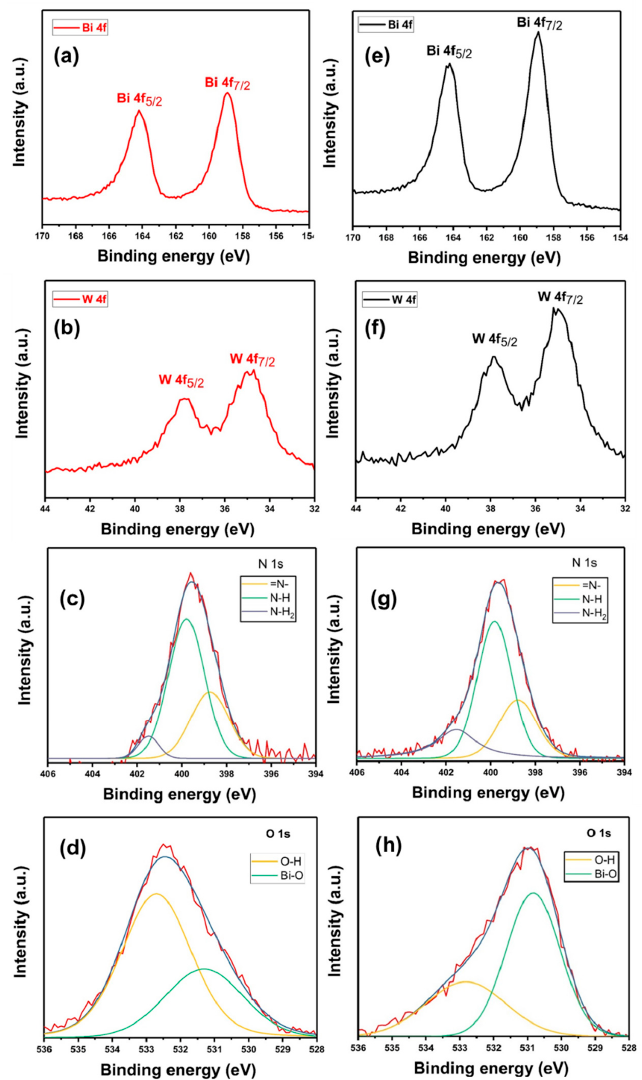
Figure 4. X-ray photoelectron spectra (XPS) ( a ) Bi 4f ( b ) W 4f ( c ) N 1s ( d ) O 1s of G/BWP/PDA and XPS ( e ) Bi 4f ( f ) W 4f ( g ) N 1s ( h ) O 1s spectra of G/PDA/BWNp.